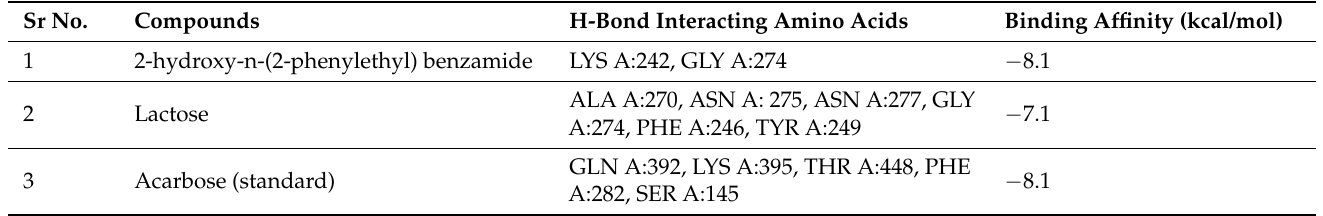
Table 6. The binding affinity of ligands, bond interaction, and bond number of GC–MS identified compounds against diabetes with α